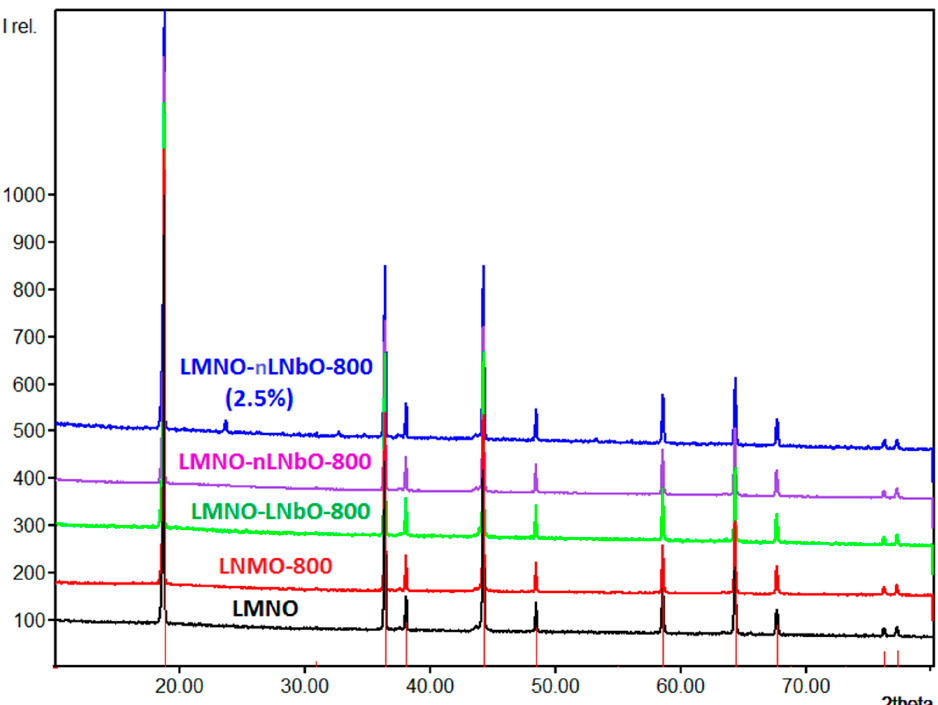
Figure 4. XRD patterns of uncoated LiMn 1.5 Ni 0.5 O 4 (LNMO), uncoated and treated at 800 °C (LNMO-800), coated with 0.5 wt.% LiNbO 3 using sol-gel method and calcined at 800 °C (LNMO-LNbO-800), coated with 0.5 wt.% LiNbO 3 using new method and calcined at 800 °C (LNMO-nLNbO-800), and coated with 2.5 wt.% LiNbO 3 using new method and calcined at 800 °C (LNMO-nLNbO-800(2.5%)).